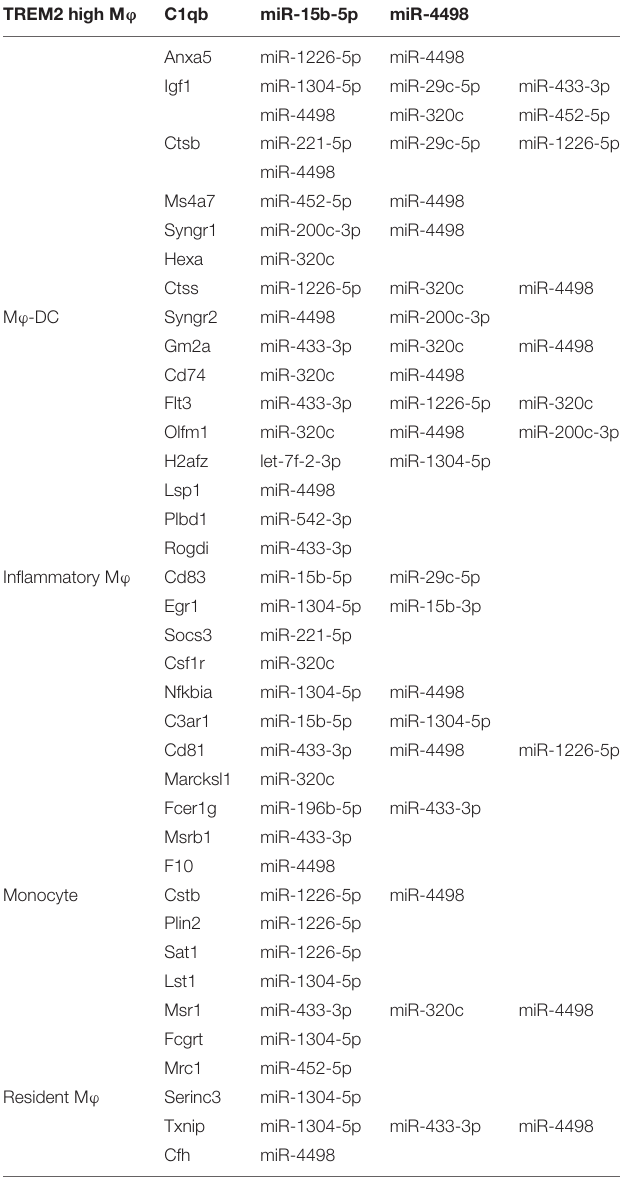
TABLE 5 | The DEmiRNAs/mRNAs in five monocyte-related